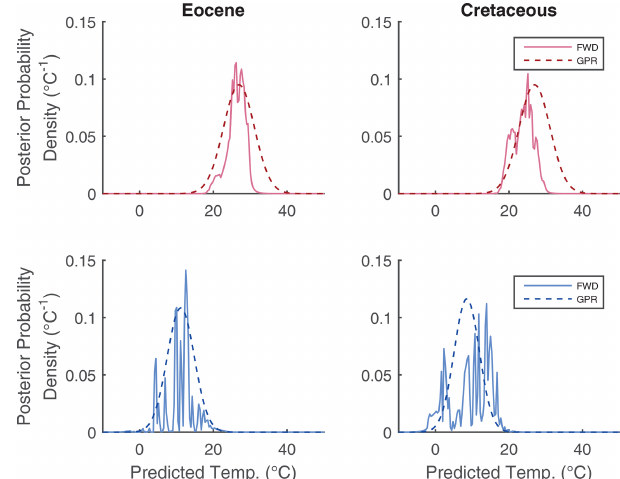
Figure 11. The posterior distributions over temperature from the forward model for selected examples of high and low temperature examples, from both the Eocene and Cretaceous. The Gaussian er- ror envelope from the GPR model is shown for